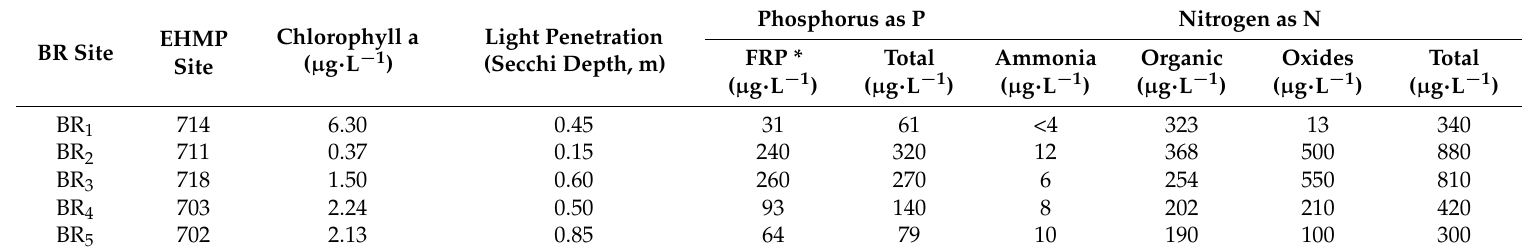
Table 2. Sample site description and EHMP site matched water quality